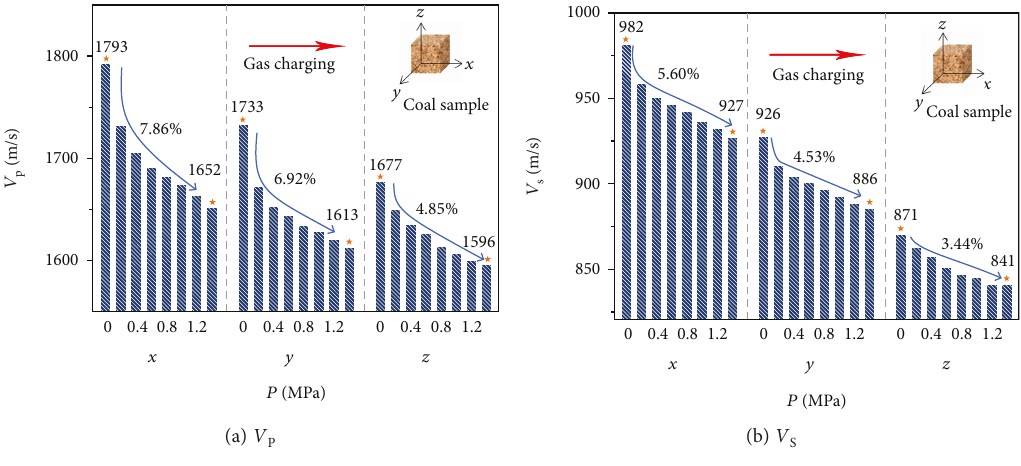
Figure 6: Measured V